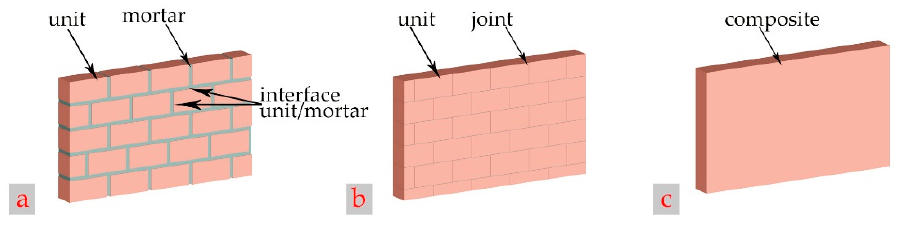
Figure 5. Modelling methods of masonry: ( a ) detailed micro modelling; ( b ) simplified micro mod- elling; and ( c ) Macro modelling.